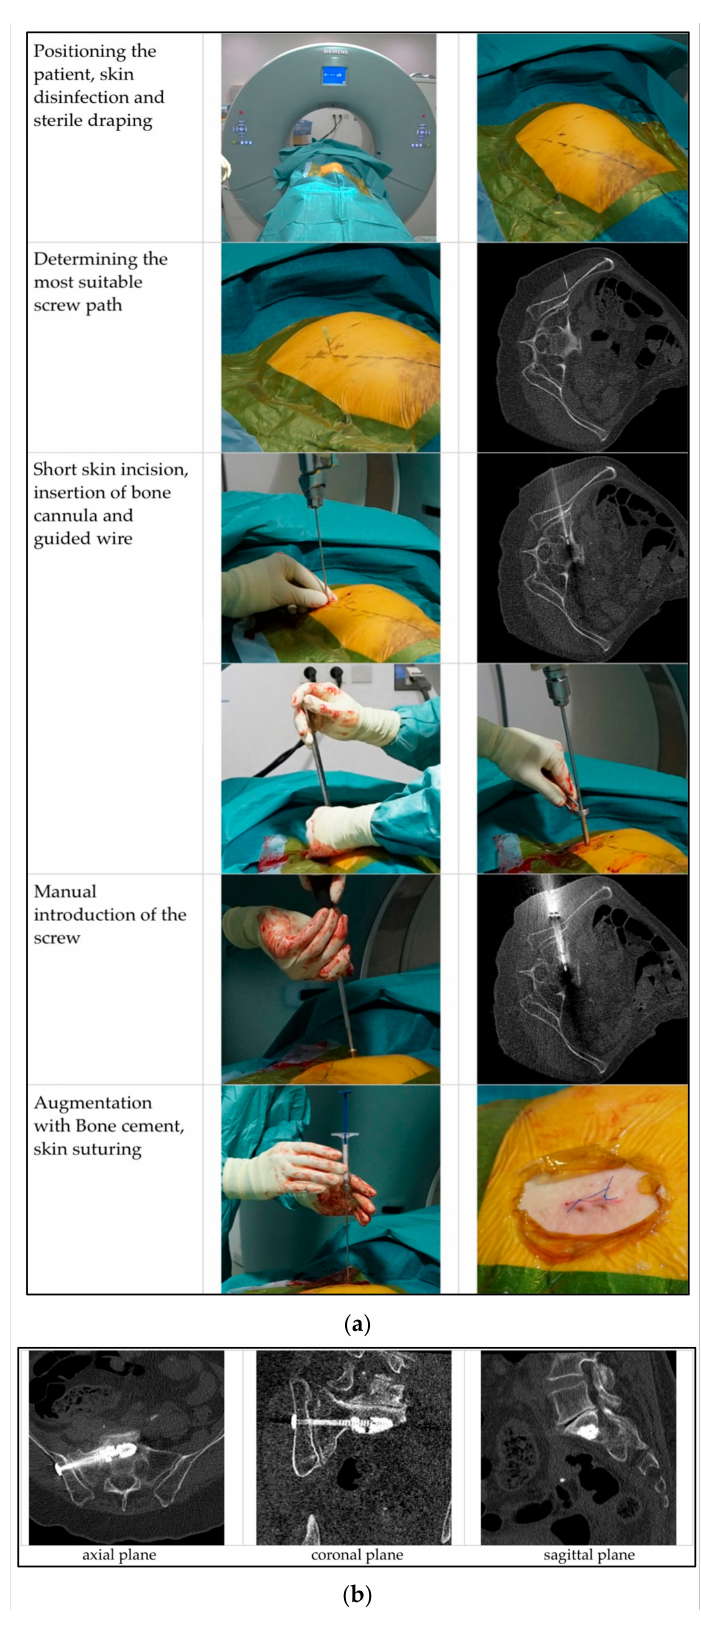
Figure 2. ( a ) Operative Procedure, ( b ) Post-operative CT-scans. The following demographical data were collected: gender, age and comorbidities at admission. The medical records were analysed for: further information on the mechanism